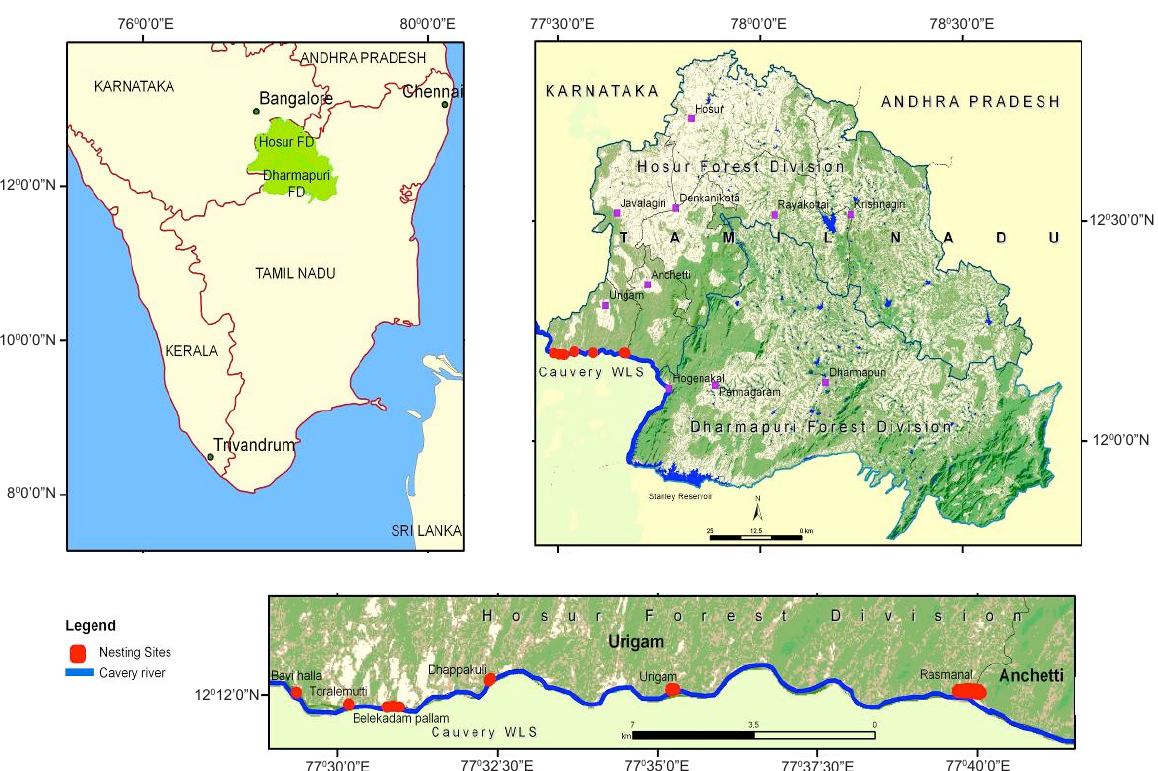
Image 2. The study area of Hosur and Dharmapuri Forest Divisions and the Grizzled Giant Squirrel distribution